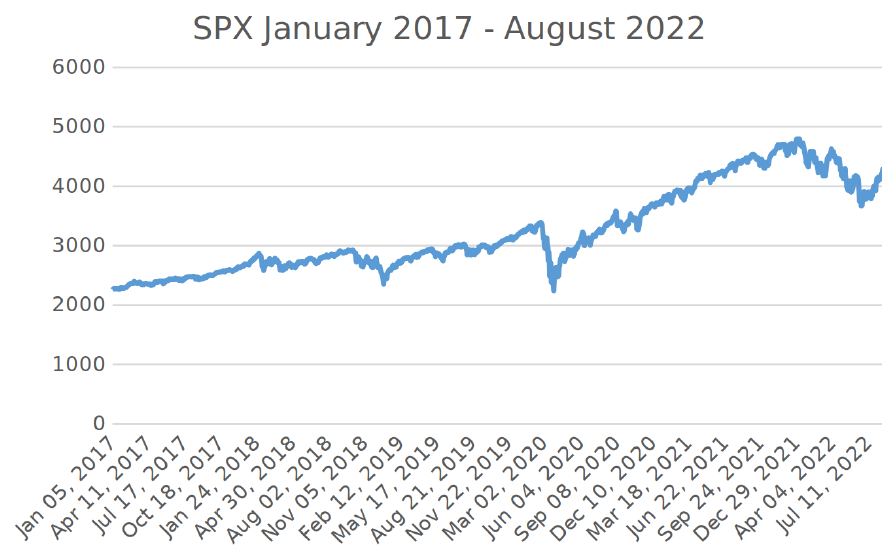
Figure 4. Chart of the S&P500 from January 2017 until August